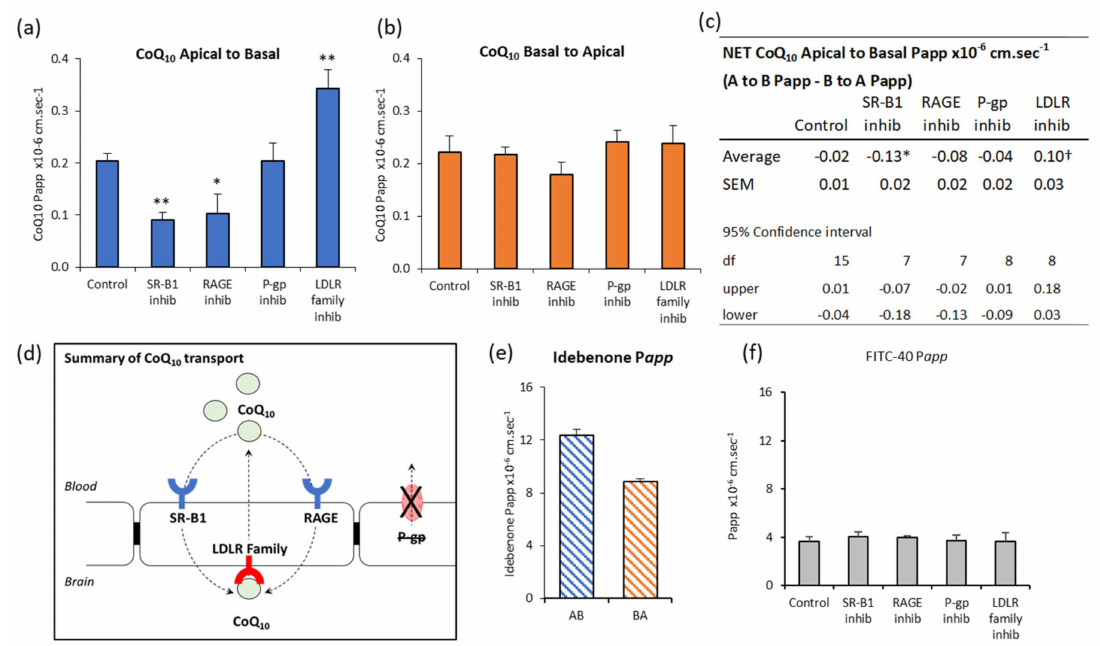
Figure 2. E ff ect of inhibitors on CoQ 10 transport across bEnd.3 BBB model. CoQ 10 (pre-incubated in serum) transport across bEnd.3 cells on Transwell filters assayed over 60 min. Inhibitors added apically and basally two hours before assay were BLT-1 (10 µ M) for SR-B1, FPS-ZM1 (1 µ M) for RAGE, receptor-associated protein (RAP) (0.5 µ M) for LRP-1 / LDLR and verapamil (0.1 mM) for p-glycoprotein. Apparent permeability, P app , shown for ( a ) Apical to Basal CoQ 10 transport, ( b ) Basal to Apical CoQ 10 transport. ( c ) The “net” transport of CoQ 10 across bEnd.3 cells, calculated from the di ff erence between A to B transport (blood-to-brain) and B to A transport (brain-to-blood). “Net” transport in control cells did not di ff er from zero (95% confidence interval). * Treatment with SR-B1 or RAGE inhibitors (BLT-1 10 µ M, FPS-ZM1 1 µ M) resulted in “net” − ve transport, i.e., “net” transport directed toward the blood side (B to A). † Treatment with LRP-1 / LDLR inhibitor RAP (0.5 µ M), resulted in “net” + ve transport toward the brain side (A to B). The p-glycoprotein e ffl ux transport inhibitor Verapamil (0.1 mM) had no significant e ff ect. (d) Schematic summary of CoQ 10 transport across the BBB. No “net” CoQ 10 entry toward brain side. Uptake by RAGE and SR-B1, is opposed by LRP-1 / LDLR mediated removal to blood, a major impediment to brain entry of CoQ 10 . (e) Transport of the CoQ 10 analogue, Idebenone (10 µ M). Apical to basal transport exceeded basal to apical, meaning there was “net” transport toward the brain. n = 4–5, Values are mean ± SEM * p < 0.05. (f) FITC-40 Apical to Basal transport; n = 8 (control), n = 4–5 (interventions); values are mean ± SEM; * p < 0.05, ** p < 0.01; ANOVA single